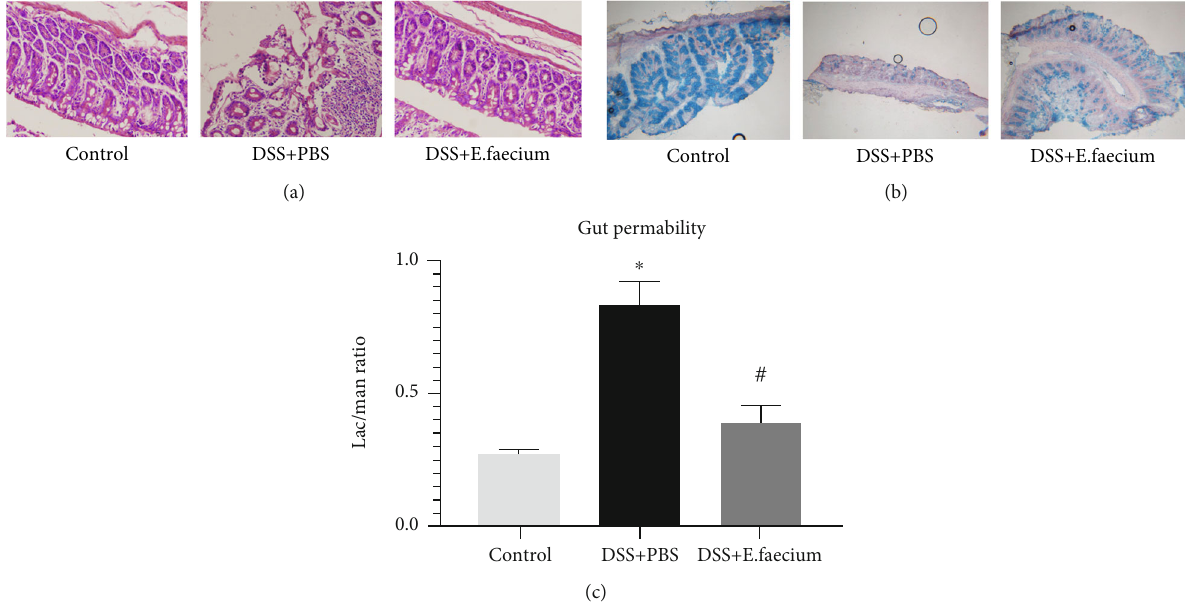
Figure 2: E. faecium restores intestinal mucosal damage induced by DSS. (a) HE staining of the colon. (b) Alcian blue staining of the colon. (c) Detection of intestinal permeability. ∗ P < 0 : 05 vs. control group; # P < 0 : 05 vs. DSS +PBS group.